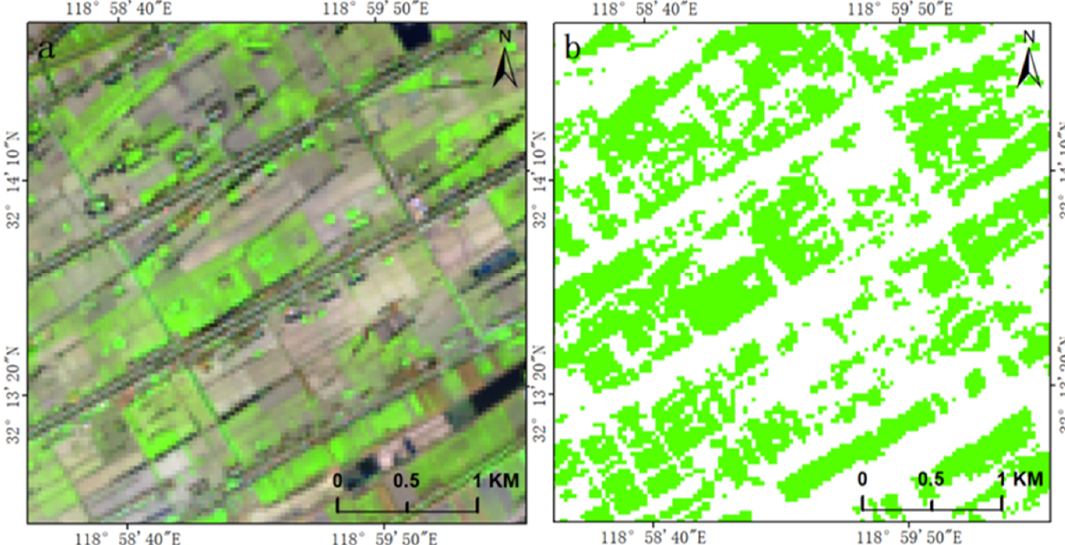
Figure 8. Farmland grown in single-phase images in winter: (a) 30-m Landsat 8 Thematic Mapper (TM) image combined as false color (6/5/4) on 9 February 2016, and (b) farmland most likely extracted as evergreen vegetation.